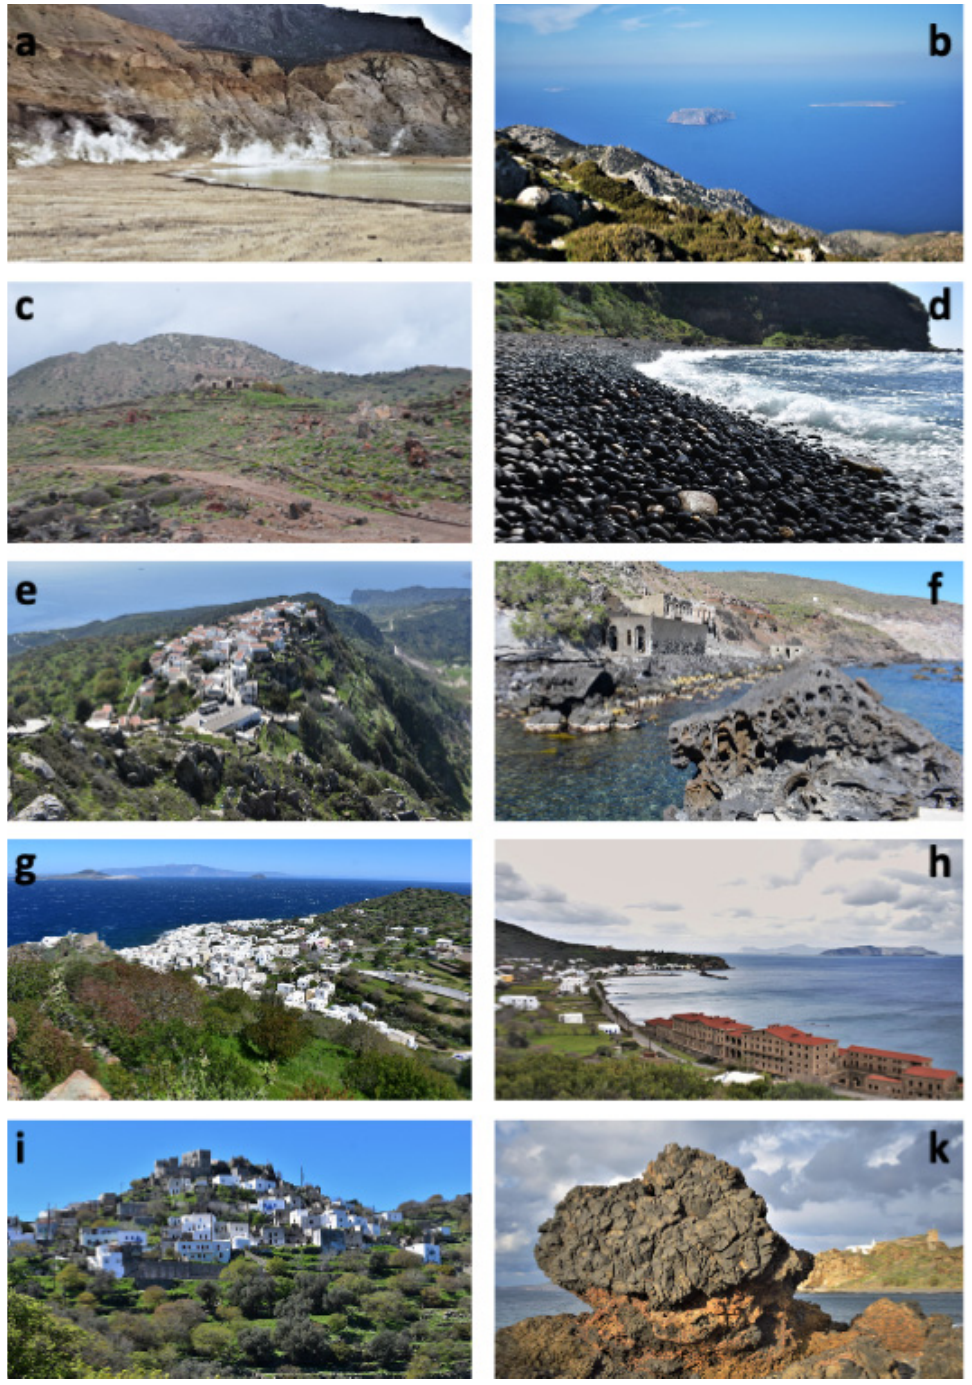
Figure 17. Representative photos for each trail available in the Story Map: ( a ) Caldera-Lakki, ( b ) Diavaris-Nymfios, ( c ) Argos, ( d ) Xoxlaki-Kanoni, ( e ) Nikia-Fylakio, ( f ) Nikia-Avlaki, ( g ) Kateros, ( h ) Pali-Lies, ( i ) Evaggelistria-Emborios, ( k ) Circumnavigation. ‘Caldera-Lakki’ trail presents a series of volcanic features representative of the geol- ogy of the island. Starting from the old and abandoned village of Emborios, it takes visi-